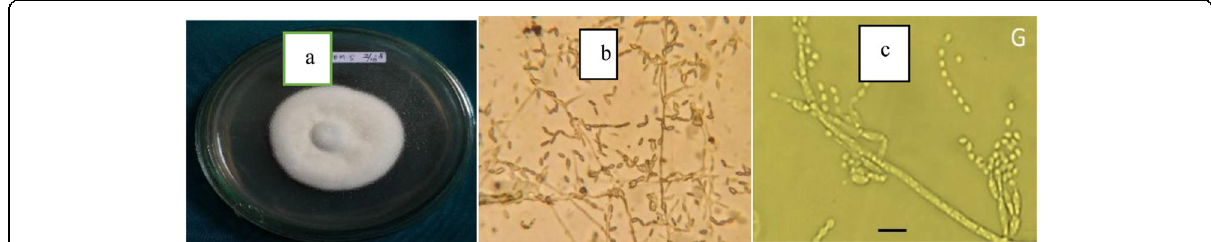
Fig. 1 a Colony of 8 days old Pasir Kulon (J22) isolate. b Paecilomyces sp. conidia (Minarni et al. 2020). c Paecilomyces lilacinus conidia (Dong et al. 2016)